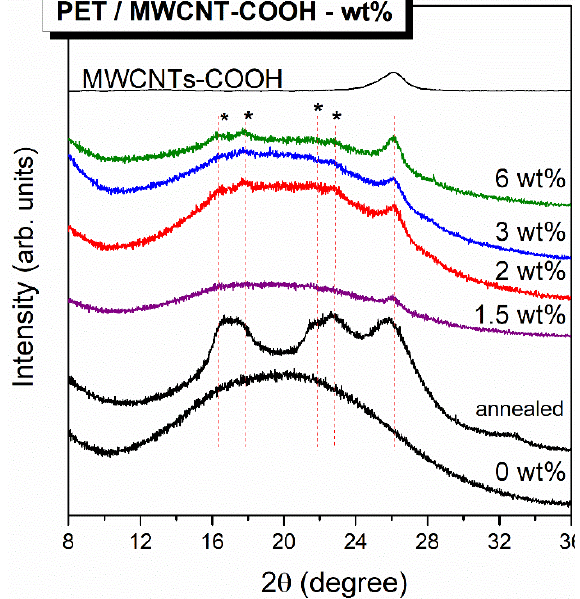
Figure 3. XRD profiles of neat PET and PET/MWCNT composites films.